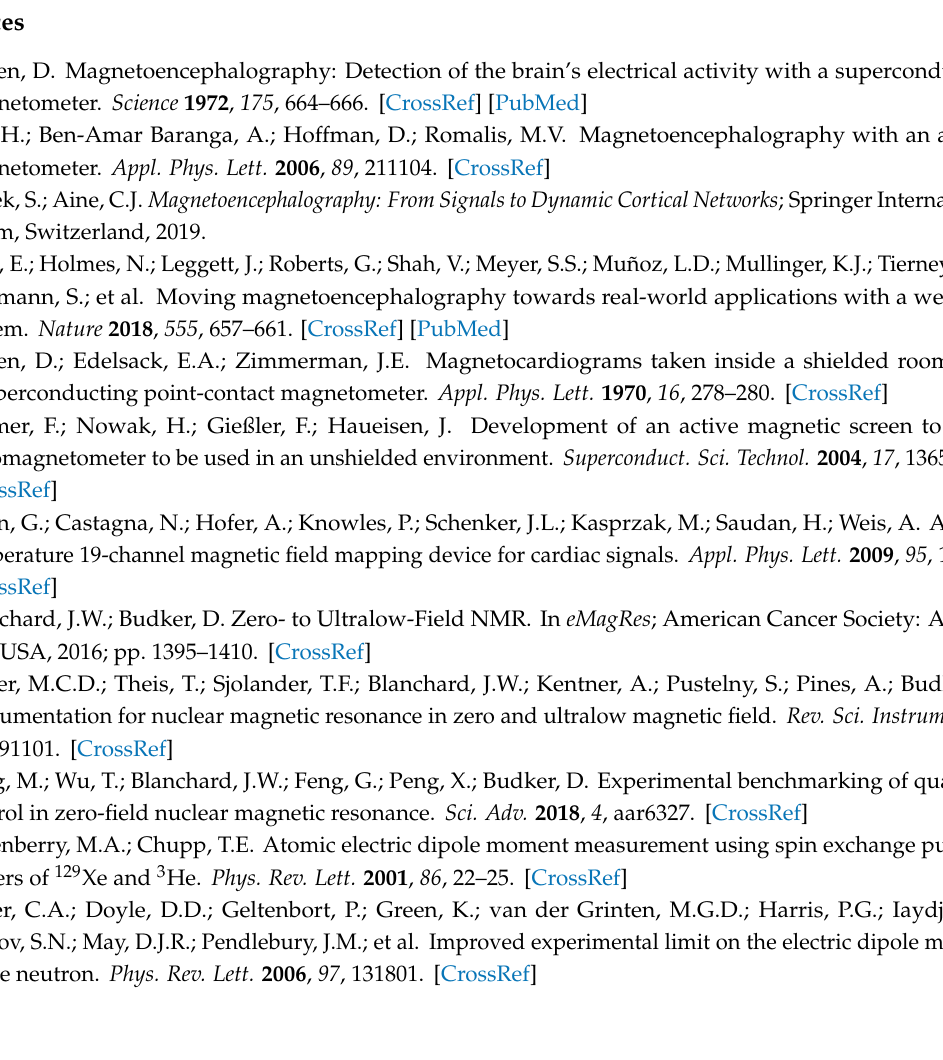
s1, Figure S1: Stability analysis based on the Nyquist diagram and Bode diagrams when the open loop transfer function G ( s ) does not have any pole on the imaginary axis, Figure S2: Stability analysis based on the Nyquist diagram and Bode diagrams when the open loop transfer function G ( s ) has a pole on the imaginary axis, Figure S3: Stability analysis based on Nyquist diagrams and Bode diagrams when the open loop transfer function G ( s ) has a double pole on the imaginary axis, Figure S4: A typical Bode diagram of the PID controller, Figure S5: A typical Bode diagram of the PI 2 D controller, Figure S6: Block diagram of the closed-loop operation of the AM NMOR magnetometer, Figure S7: The influence of the PID coefficients on the magnetic-field stabilization system, Figure S8: Noise spectral density at different